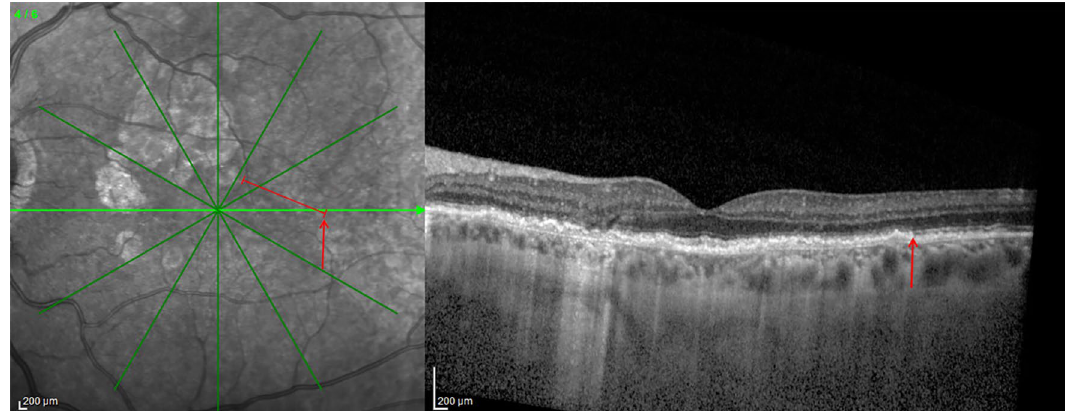
Figure 5. IR + OCT image showing a diffuse Bruch-RPE splitting. After identifying on the OCT B-scan the point where the ellipsoid zone faded, its distance from the closest edge of the atrophy was measured on the corresponding IR image (1856 μm in this